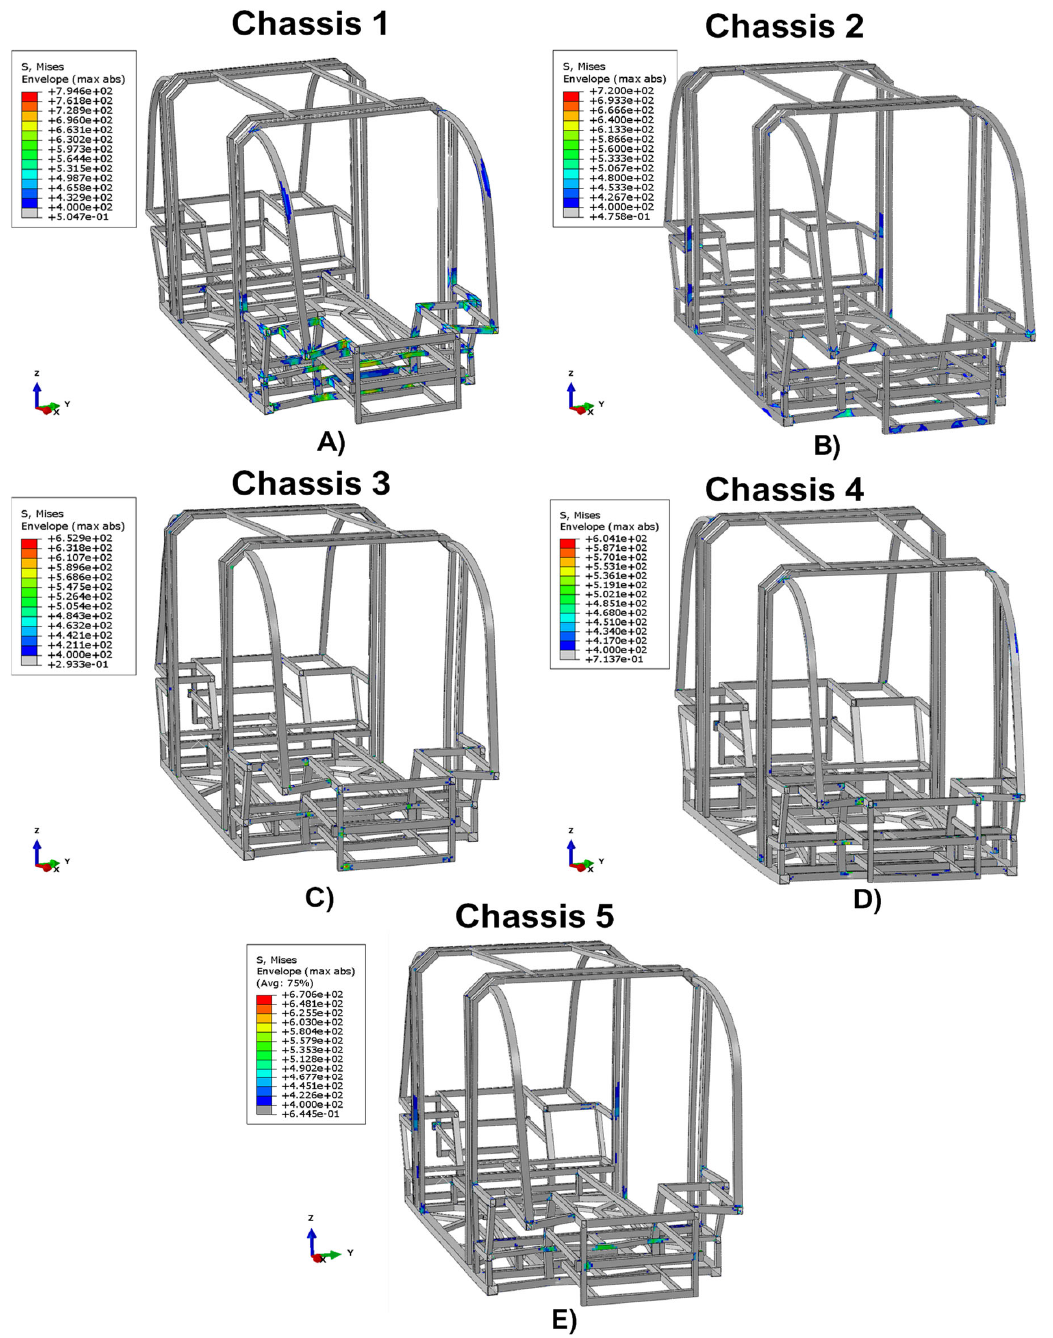
Figure 10. Comparison with stress exceeding 400 MPa. ( A ) Chassis 1, ( B ) Chassis 2, ( C ) Chassis 3, ( D ) Chassis 4, and ( E ) Chassis 5. ( D ) Chassis 4, and ( E ) Chassis